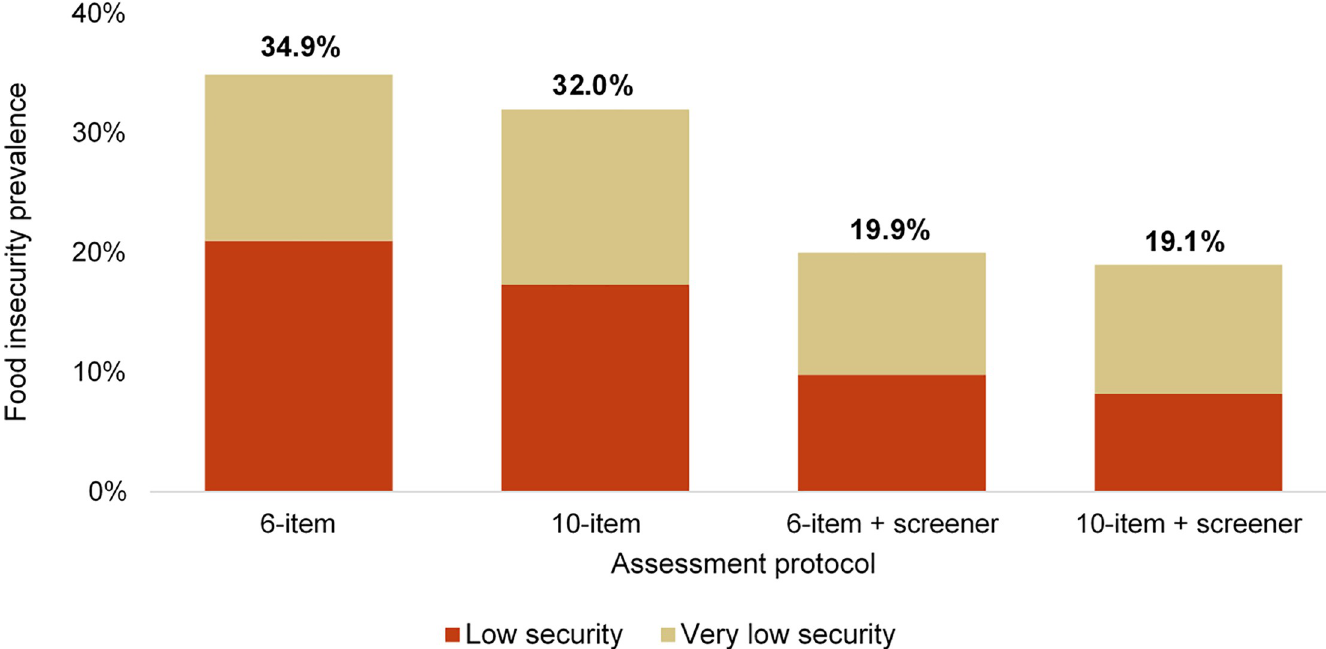
Fig 1. Prevalence rates of food insecurity among undergraduate college students by assessment protocol (n = 462). Note. Assessment procedures and scoring protocols being compared are the: 1) Six-Item Short Form of the USDA Food Security Survey Module; 2) 10-item USDA Adult Food Security Survey Module; 3) Six- Item Short Form with two screening items used in the Current Population Survey; and 4) 10-item USDA Adult Module with two screening items used in the Current Population Survey.